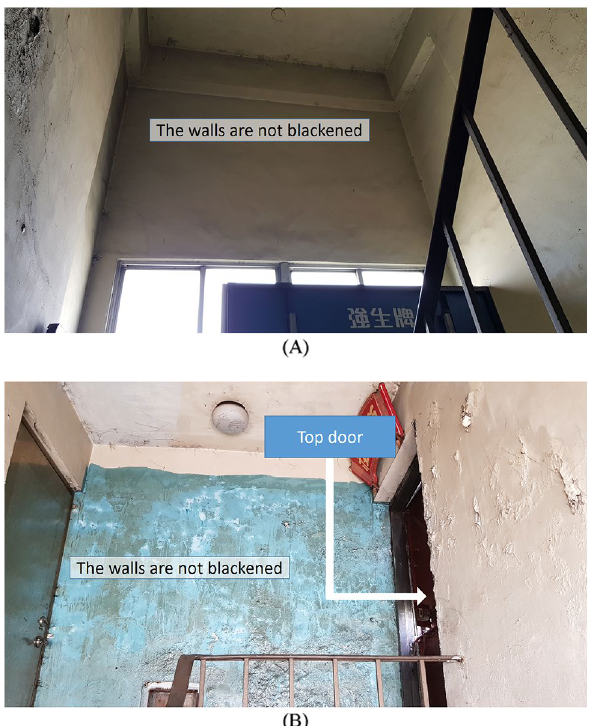
Figure 6. Description of the highest position of the fire ( A ) The highest platform of the stair was not blackened by hot smoke. ( B ) The highest floor of the stair was not blackened by hot smoke.